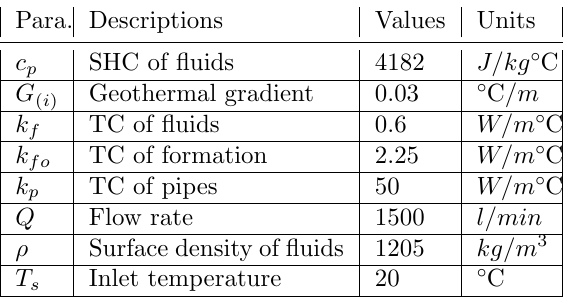
Table 1: Base case parameters